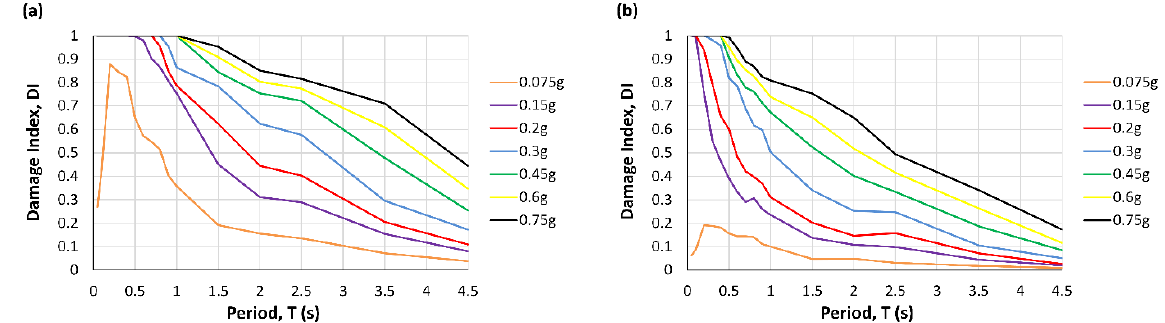
Figure 5. DI spectra for various PGA range by ( a ) Park and Ang [18] DI spectral functions and ( b ) Moric et al. [19] DI spectral